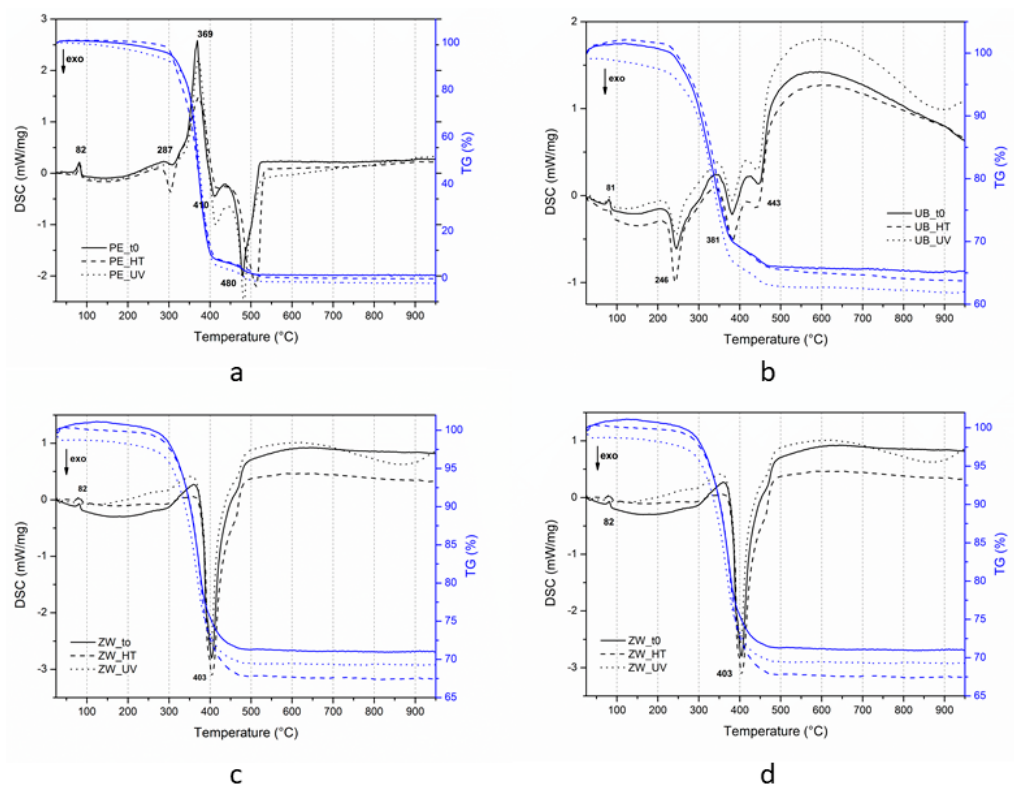
Figure 9. TG-DSC curves of un0aged (t0), high temperature (HT) and UV aged mock-ups: ( a ) Edelwachs (PE); ( b ) ultramarine blue (UB); ( c ) titanium white (TW); ( d ) zinc white (ZW). Table 7. Total weight loss % and glass transition temperature (Tg) of the un-aged and aged mock- ups.